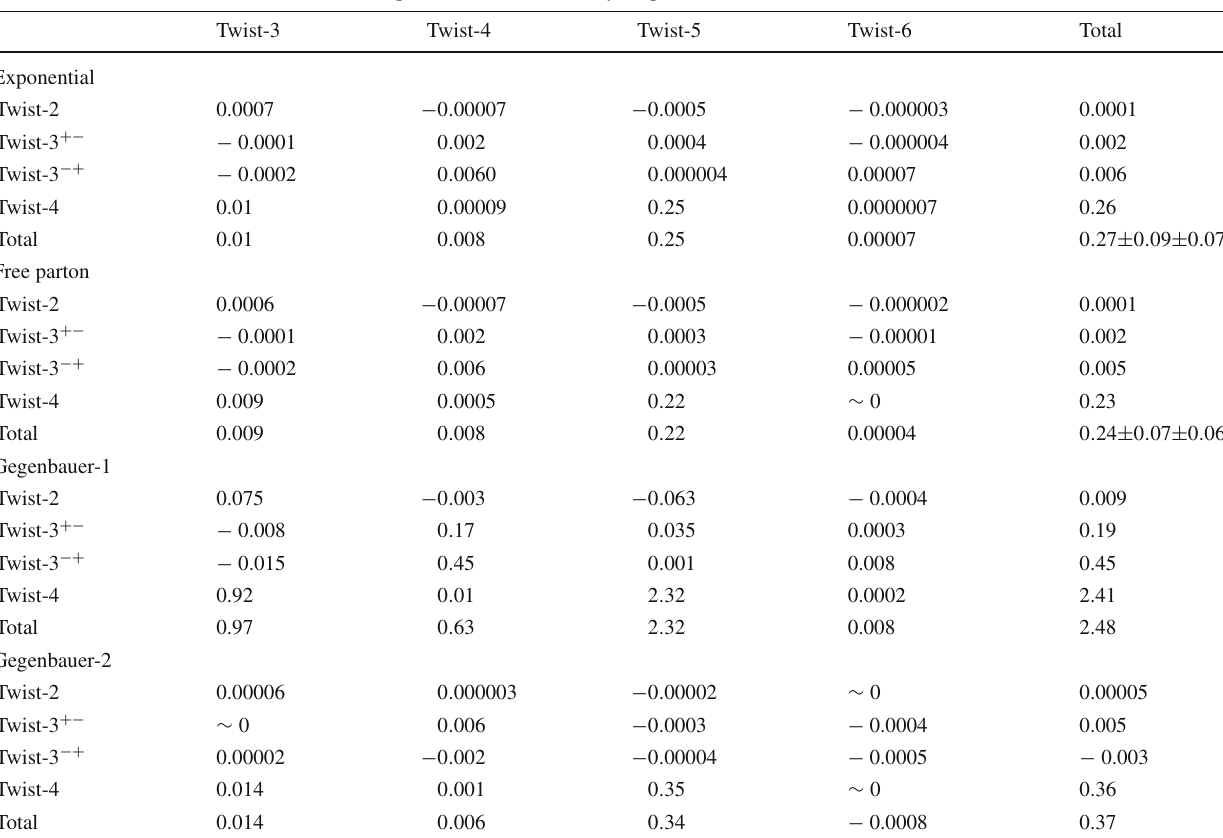
Table 4 Form factor f 1 ( 0 ) from various twist combinations of the (cid:2) b baryon and proton LCDAs. The first (second) theoretical errors of the total results come from the variations of the relevant parameters in the (cid:2) b baryon (proton)